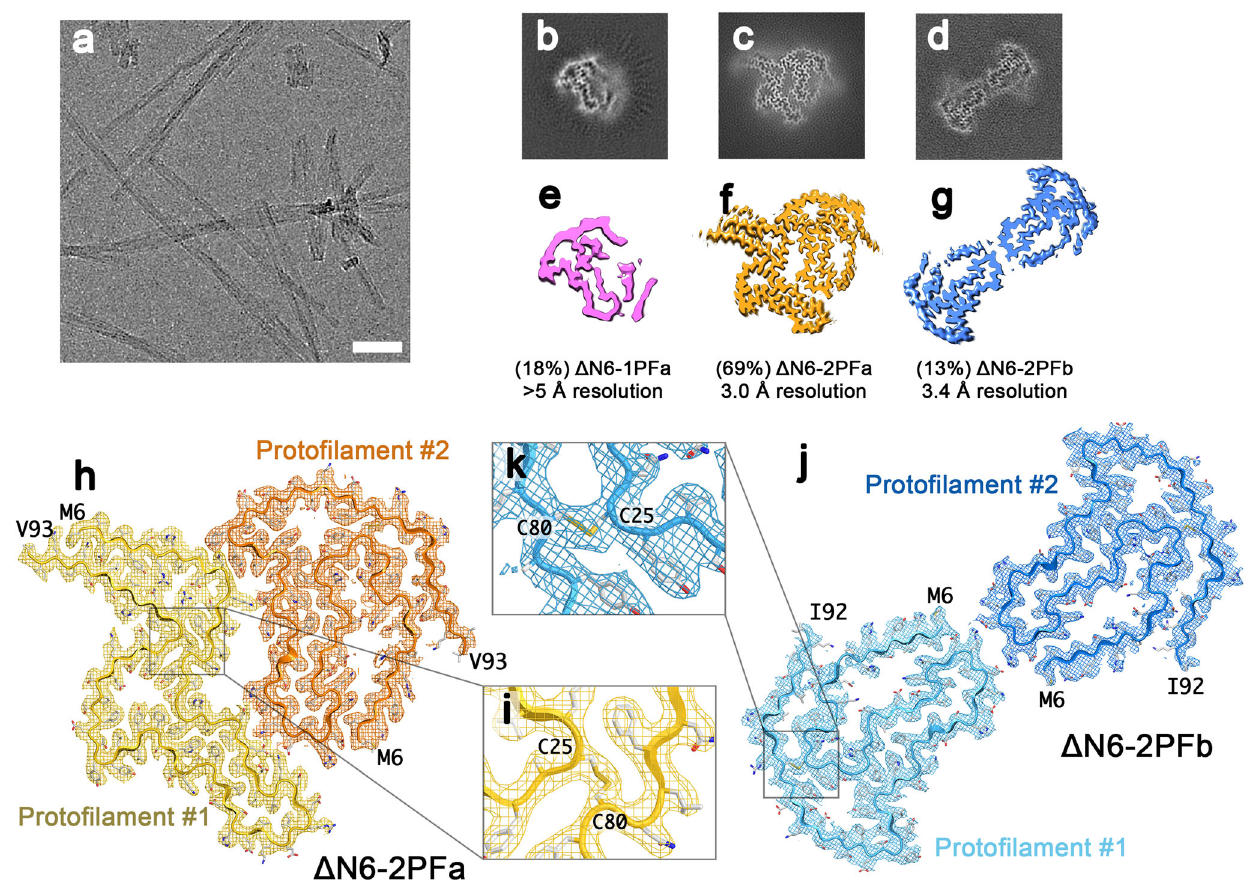
Δ N6-2PFa structure with its accompanying atomic model. Proto fi lament #1 is in yellow,andproto fi lament#2isorange.TheEMdensityisshownasamesh,andthe atomic model as a cartoon with the same colour, and sidechains coloured according to a CPK scheme. i The disulphide bond between residues 25 and 80 is present and well-resolved. j , k , as for h , i , but showing the 3.4Å structure of Δ N6- 2PFband theaccompanyingatomicmodel,withproto fi lament#1inlightblue,and proto fi lament #2 in darker